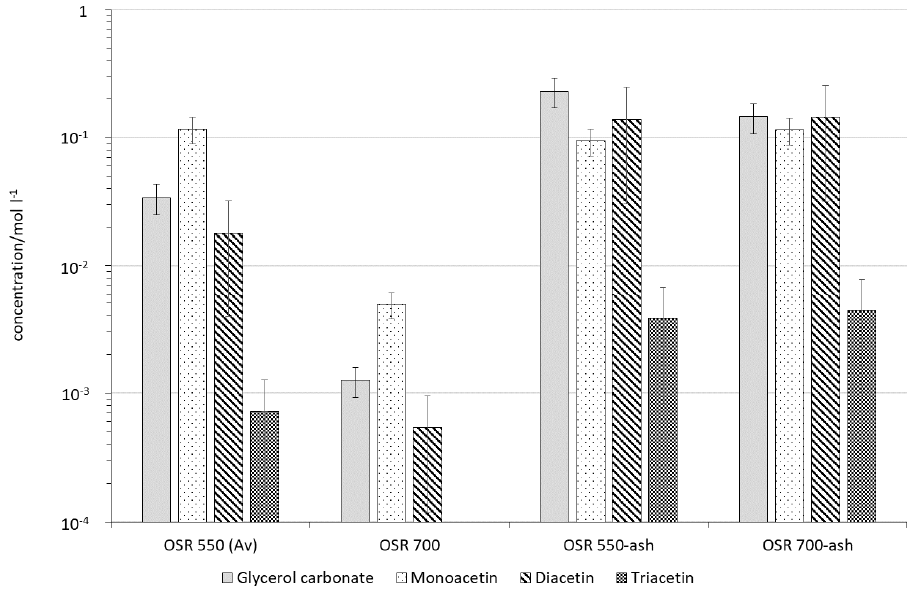
Figure 9. Concentration of glycerol carbonate and acetins produced using oil seed rape (OSR) biochars produced at di ff erent pyrolysis temperatures, and their ashes. A logarithmic y -axis is used to present high and low concentration